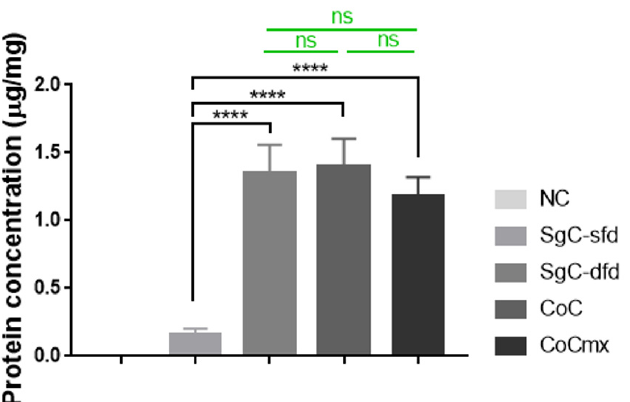
Figure 9. Protein concentration of cationized hydrogels (20% DEAE – Dextran) with spatial-control coating. Statistical analysis was performed using a one-way ANOVA. **** p < 0.0001.